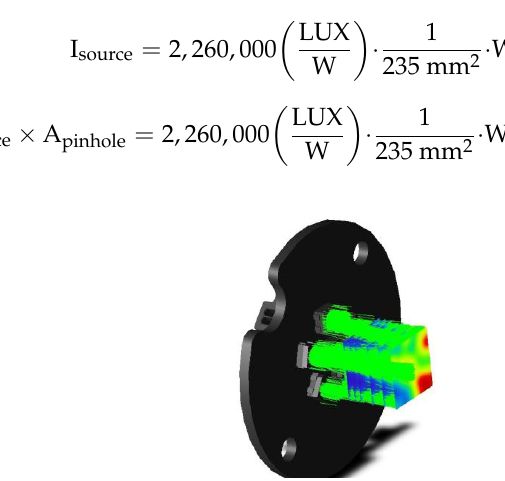
Figure 17. Output example of the ZEMAX simulation of the light source.